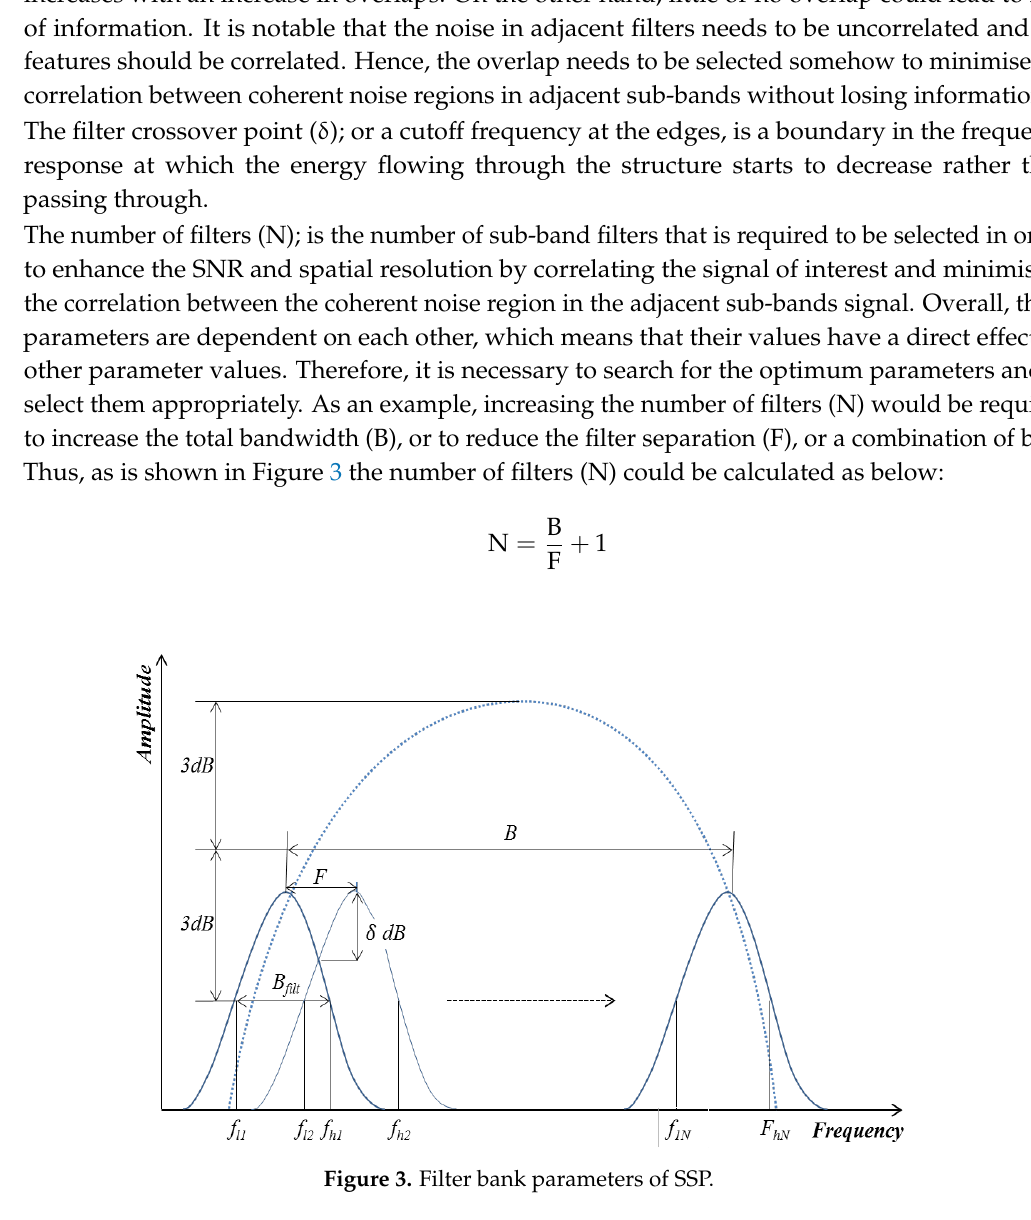
Figure 3. Filter bank parameters of SSP.